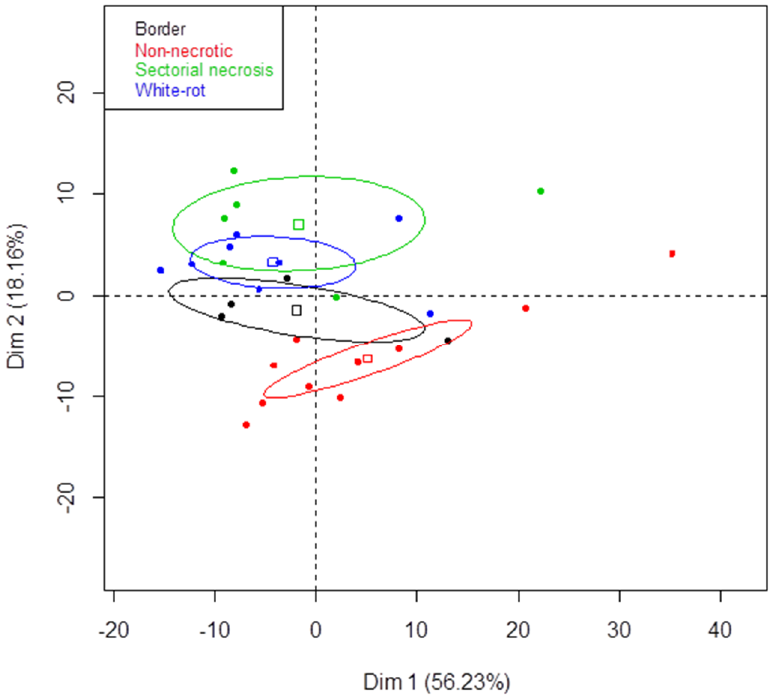
Figure 1. Principal component analysis (PCA) of SSCP profiles of fungal microbiota from woody tissues of untreated grapevines sampled in 2014. SSCP profiles of fungal communities from woody tissues of untreated grapevines from the three regions sampled were analyzed using PCA. The % of total variation explained by each axis is given in brackets. Ellipses represent the 95% confidence intervals for microbiota from each type of tissues (non-necrotic, red; white-rot necrosis, blue; sectorial necrosis, green; border, black).